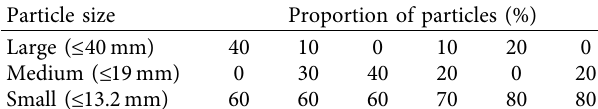
Table 2: Proportion of different particle sizes in each group. Particle size Proportion of particles (%)